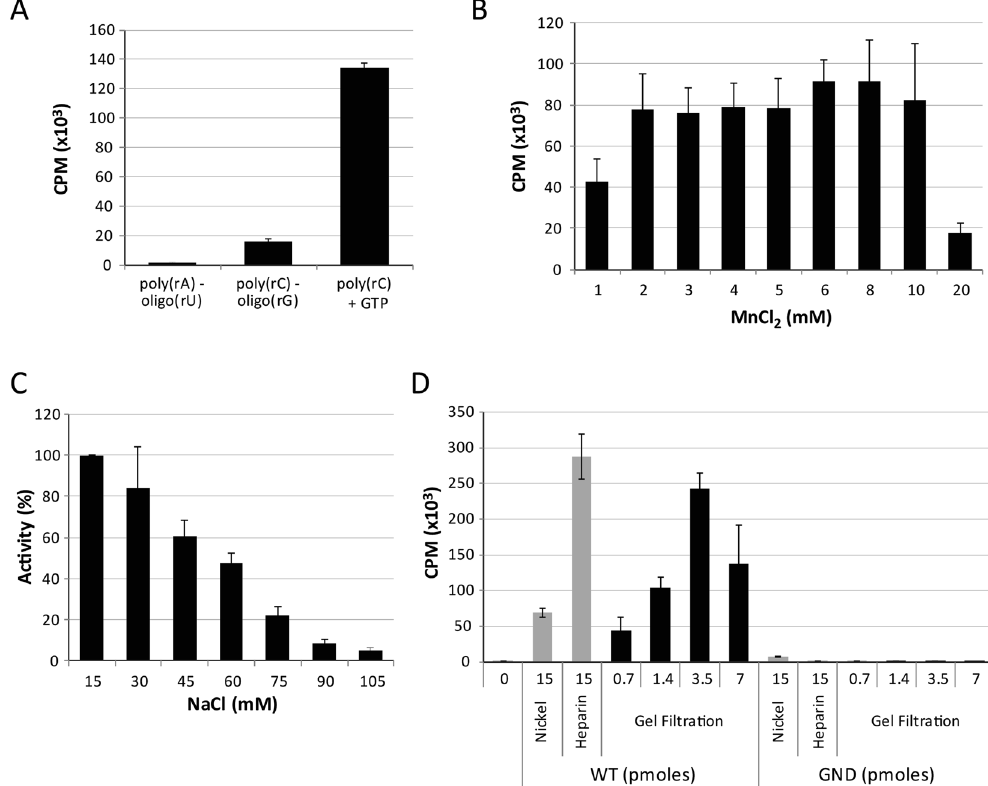
Figure 2. ZIKV RdRp enzymatic activities using homopolymeric templates. ( A ) Template utilization by ZIKV RdRp. Radionucleotide incorporation was monitored using 3.5 pmoles of WT enzyme (fraction D7 from gel filtration, see Fig. 1B) and various template-primer combinations. ( B ) Effect of the metal cofactor on nucleotide incorporation. ( C ) Impact of increasing concentration of NaCl on radionucleotide incorporation. The assay was conducted in conditions similar to panel A using the poly(rC) substrate and increasing concentrations of MnCl 2 and NaCl, respectively. Because the RdRp was purified in a buffer containing NaCl, the lowest salt concentration reachable is 15 mM (no salt added). ( D ) De novo RNA synthesis activity of ZIKV RdRp throughout the purification stages. Pooled fractions eluted from the nickel column and from the heparin column were tested at 15 pmoles of total proteins for the WT and GND mutant polymerases. In parallel, fraction D7, corresponding to the main retention pic after gel filtration was assayed at 0.7, 1.4, 3.5 and 7 pmoles. Means and standard deviations derives from three independent